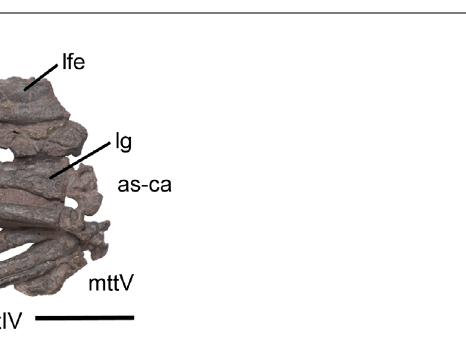
Figure 11. Left hindlimb of Chanaresuchus ischigualastensis (PVSJ 567) in anterior view. Abbreviations: as-ca, astragalus-calcaneum; lfi, left fibula; lfe, left femur; lg, lateral groove; lti, left tibia; mttII–V, metatarsals II–V. Scale bar equals 5 cm.